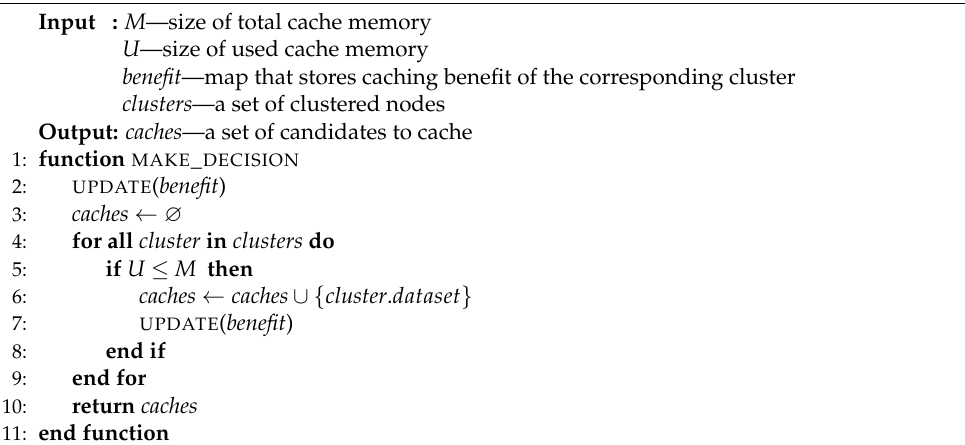
Algorithm 2 A baseline algorithm for making a caching